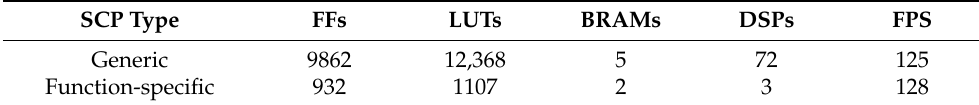
Table 4. Comparison between a generic and a function-specific